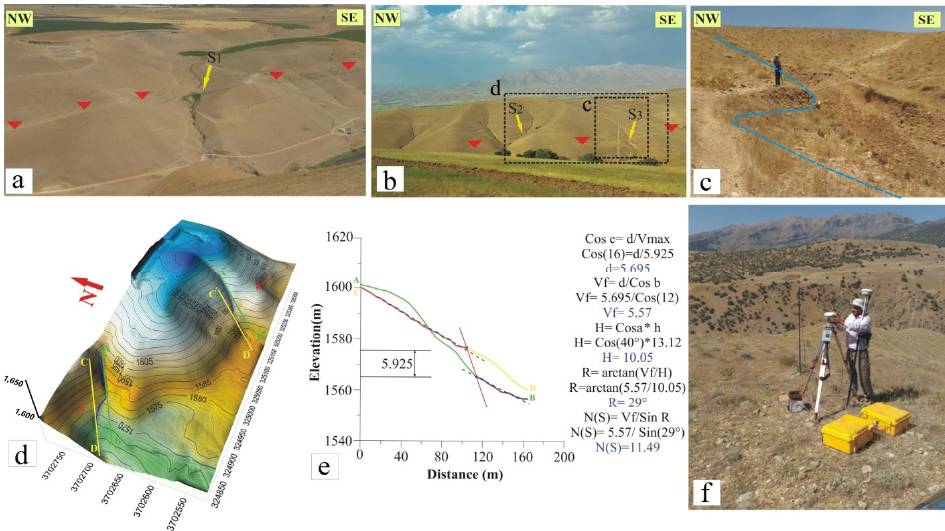
Figure 7. The detailed topographic and field photographs of the geomorphic features along the Doroud Fault: ( a , b ) Field photographs of the gullies S1, S2, and S3 (about them, read the text). The red triangles indicate fault trace. The yellow arrows indicate the location of the gullies. ( c ) Field photograph of the ideal gully offset along the Doroud Fault to determine fault slip rate and OSL sampling site (using GPS (RTK) surveying). The blue line indicates river. ( d ) The 3-D view of the digital elevation model (DEM) obtained from the GPS kinematics survey (red arrows are the fault trace, and green and yellow lines are shifted crest lines within the hanging wall and the footwall, respectively). ( e ) The diagram for the calculation of the slip rate of the Doroud Fault. Vertical profiles along the offset crests’ axes, with estimates of the cumulated vertical component, are shown on the diagram. The minimum value corresponds to the difference in height between the highest points in the violet footwall profiles and the lowest points in the orange hanging wall profiles. The maximum value corresponds to the vertical separations between the projections of the footwall and hanging wall profiles on the fault (consider a fault plane with a dip of 72°). Diagram defining the parameters for the calculation of the rake (R) of the slop. In order to calculate ( c ): H = horizontal component; V = vertical component; Vf = vertical component projected along the fault; α = dip of the fault plane (Cos c^ = d/v, c^ + p^ + b^ + 90° = 180°, b^ = 90°-c^-p^, Vf = d/cos b^, R^ = arctgVf/H, h = cosp^xVf; α = arctg h/H). ( f ) Our RTK GPS systems provide digital elevation model (DEM), map, and fault slip rate.